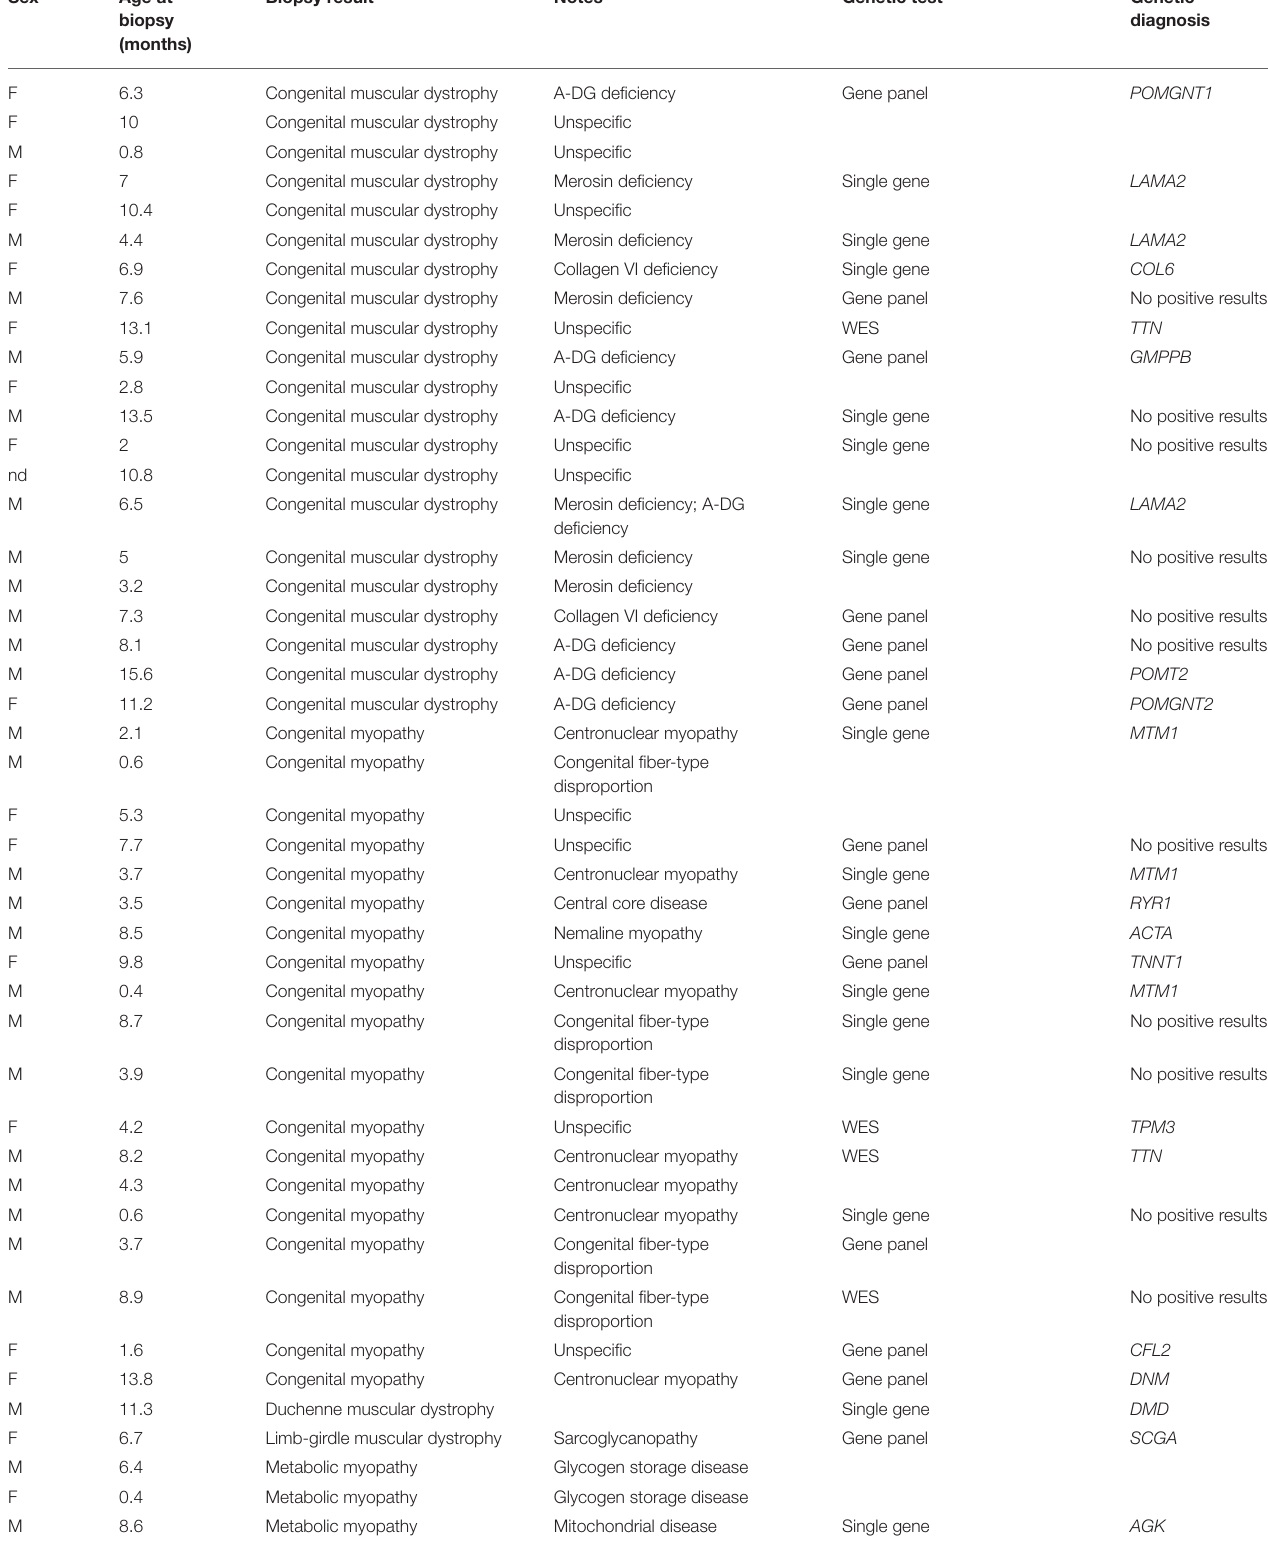
TABLE 1 | List of the different biopsy categories, including further specific findings at supplemental methods, age at biopsy, genetic tests, and result (when available). Sex Age at